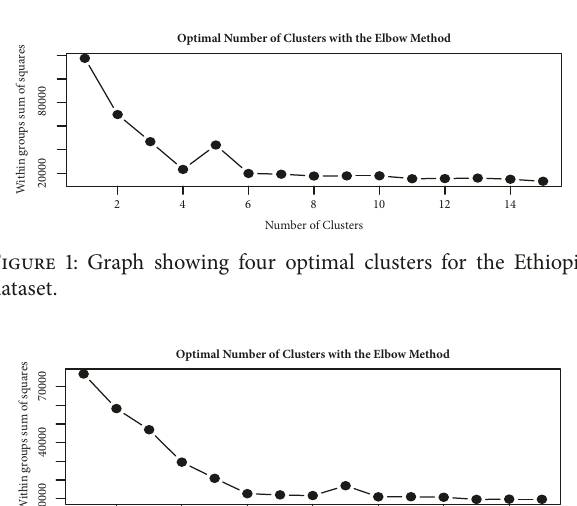
Figure 3: Household allocation to four clusters using the K-means model for Ethiopia dairy